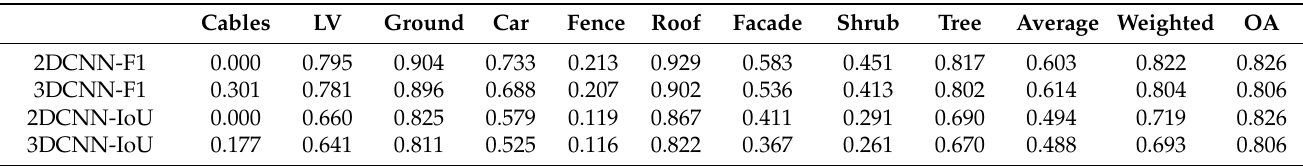
Table 7. Average and weighted F1 and IoU scores for 2DCNN and 3DCNN classifiers on the ISPRS Vaihingen dataset (LV: low vegetation). The OA is also reported.